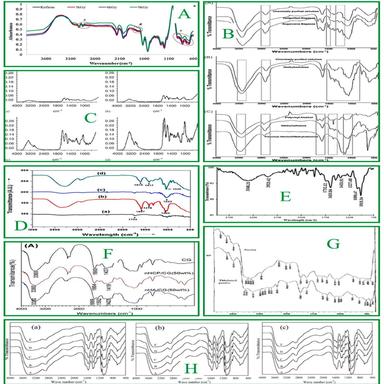
FTIR Spectral analysis of the common biopolymer and biopolymer composites, ATR-FTIR absorption spectra of kefiran film and gamma-irradiated kefiran , (A)(a) purified cellulose, delignified bagasse, and sugarcane bagasse (b) purified cellulose and methylcellulose (c) polyvinyl alcohol, methylcellulose, and polyvinyl alcohol/ methylcellulose porous composite, (B)Gelatin films with (a) 0%; (b) 15%; (c) 30%; and (d) 45% glycerol , (C)(a) pectin, (b) carboxymethyl cellulos